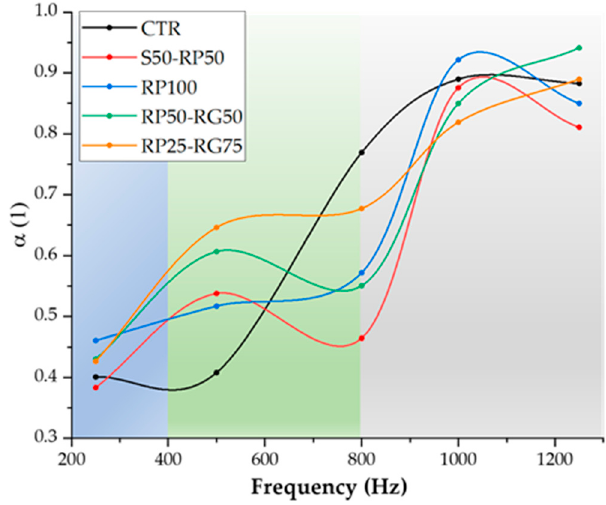
Figure 14. Variation of the acoustic absorption coefficient ( α ) with frequency: test results.